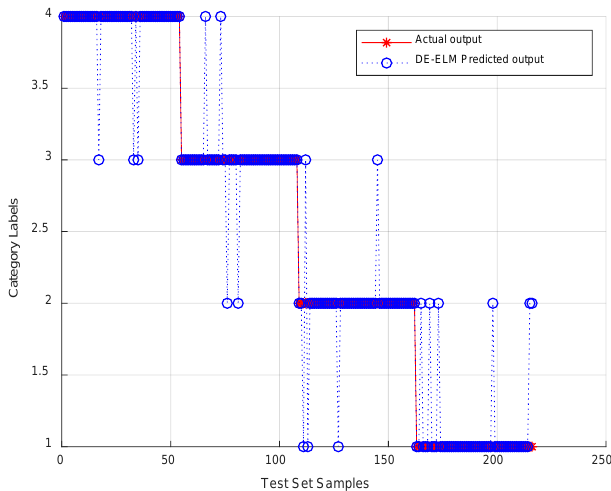
Figure 11. DE-ELM (150 nodes)-based fatigue state detection results.